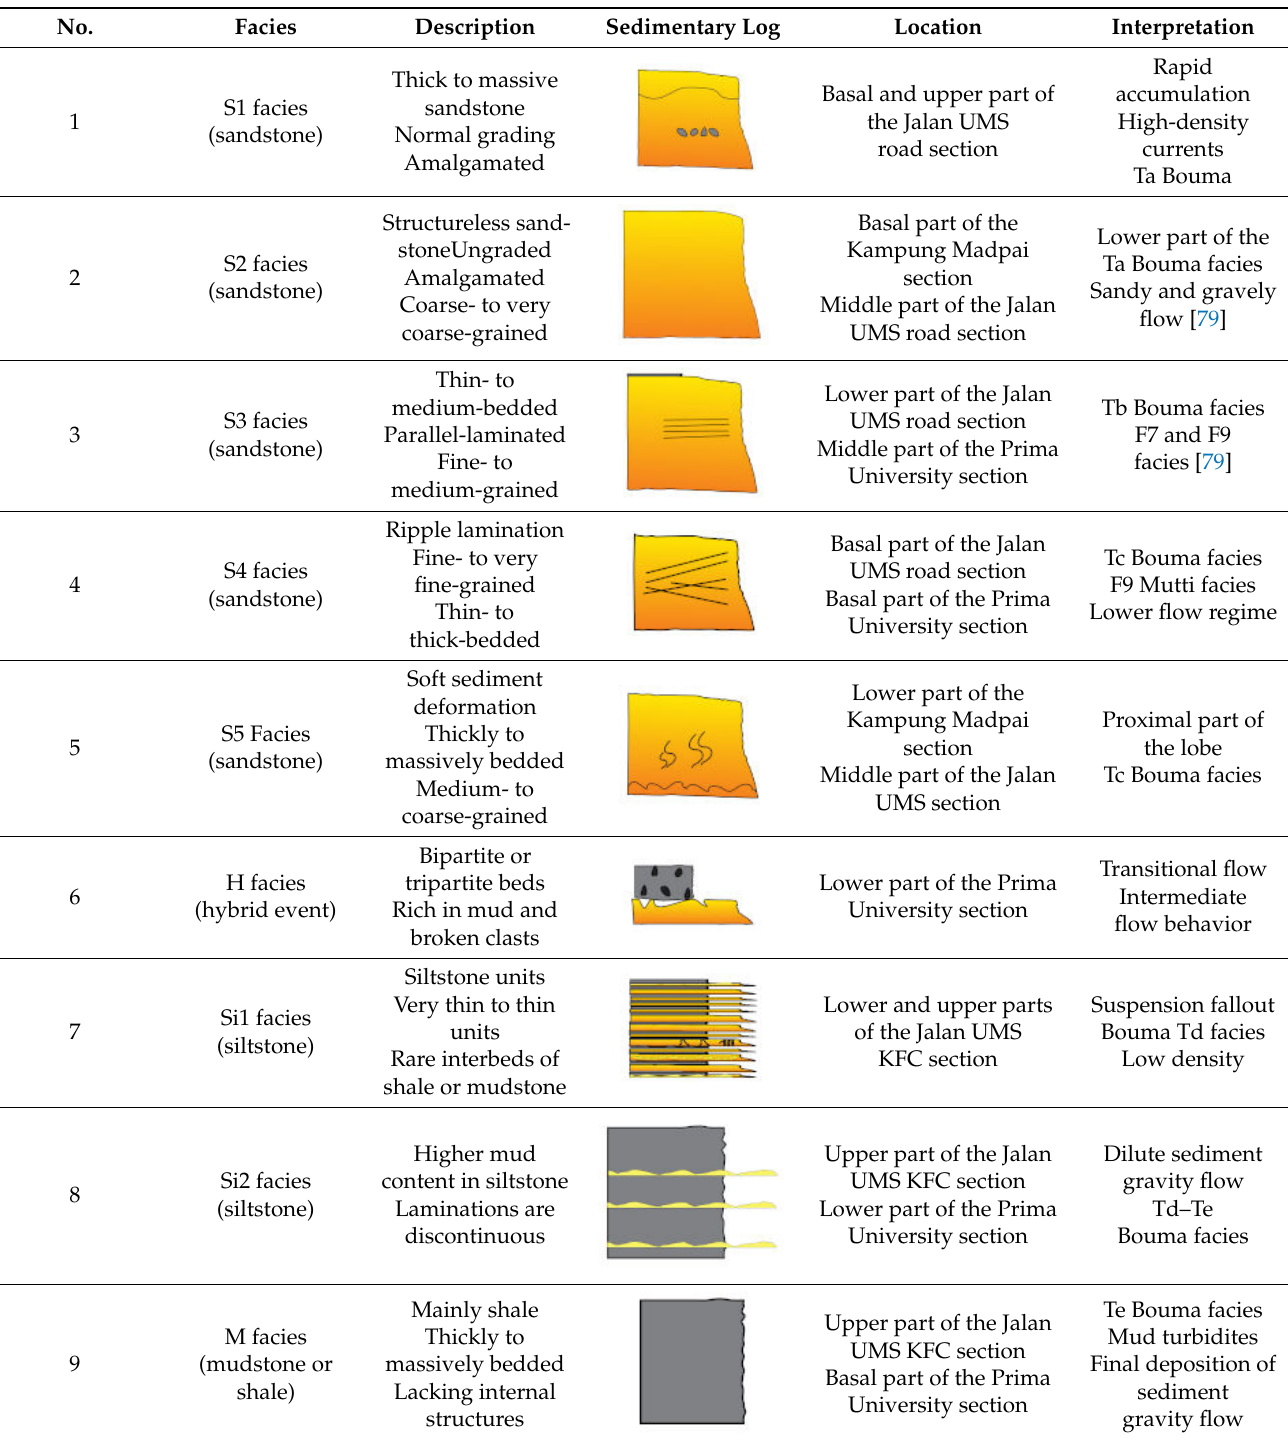
Table 1. Summary of sedimentary facies, with their descriptions, outcrop locations and